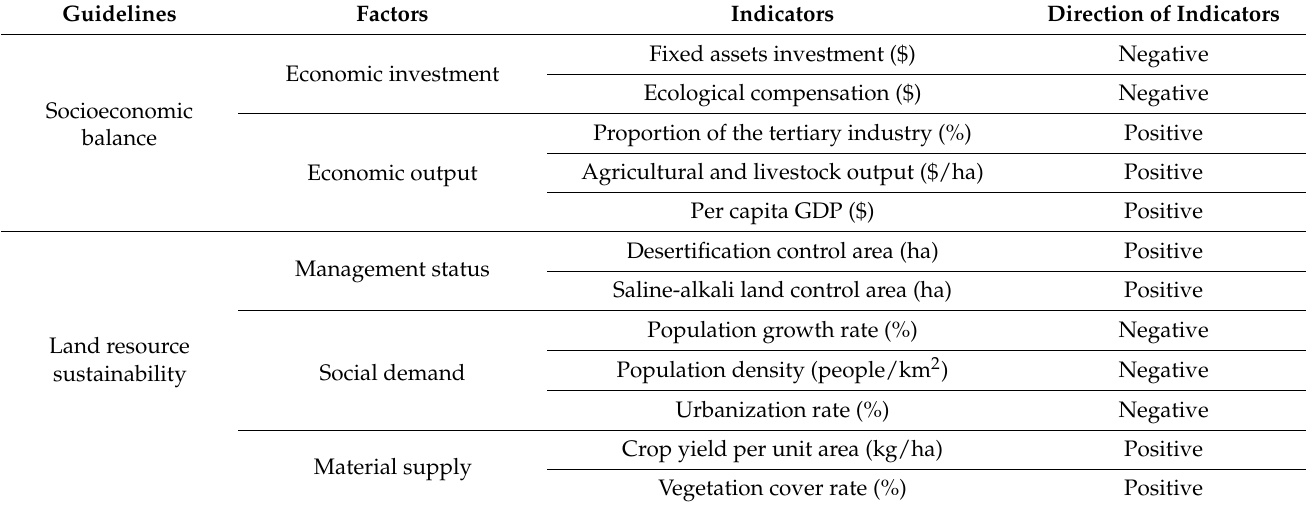
Table 3. Index system of the socioeconomic and land resource sustainability (SLS) evaluation model.